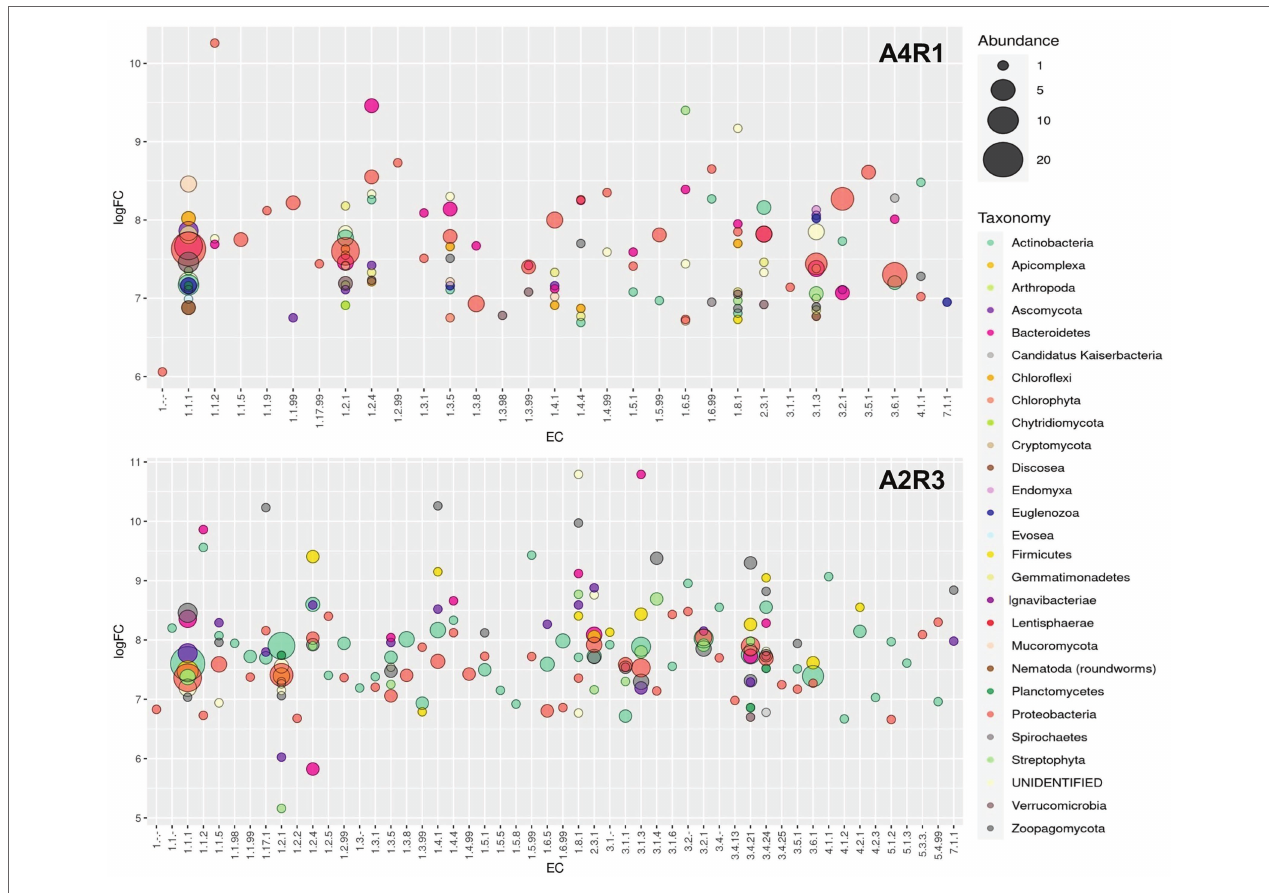
FIGURE 5 | Enzyme overexpression profile. Bubble plot showing the identified enzymes profile in the two sample (A4R1 and A2R3). Data refer to the overexpressed (at least 5 logFC) enzymes of interest. The plot shows the enzyme class (EC) and the average logFC. Enzymes were categorized according to taxonomy (different colors indicate the Taxonomic Phyla) and abundance (different sizes represent the number of identified enzymes belonging to each